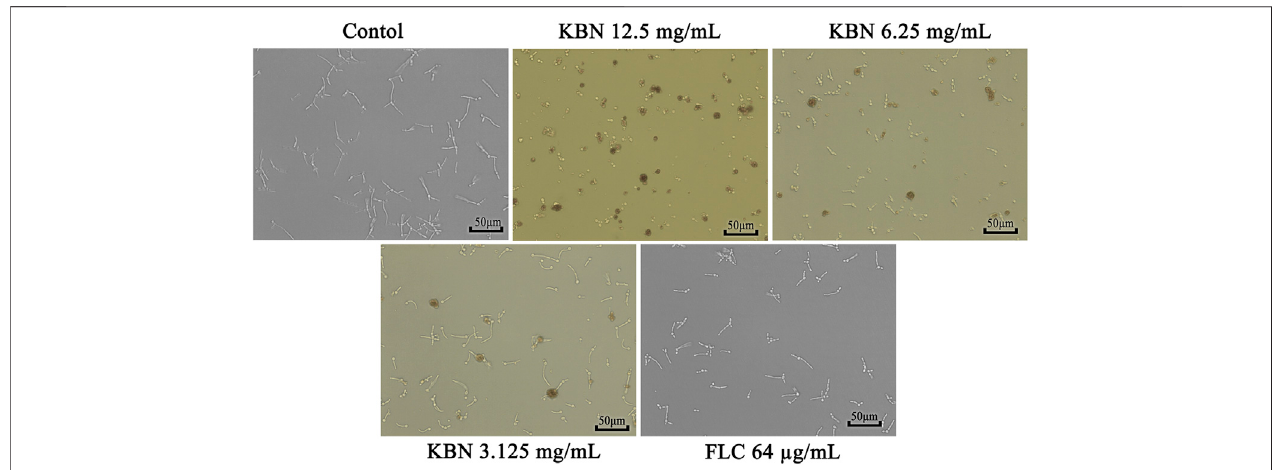
FIGURE 5 | Effects of KBN on hyphae growth of FLC-resistant C. albicans 901. The cellular morphology was photographed after incubating at 37 ° C for 3 h.